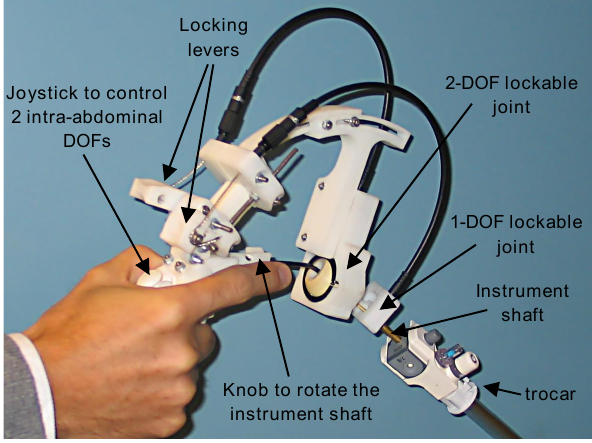
Figure 1. Prototype of articulated handle with lockable joints.